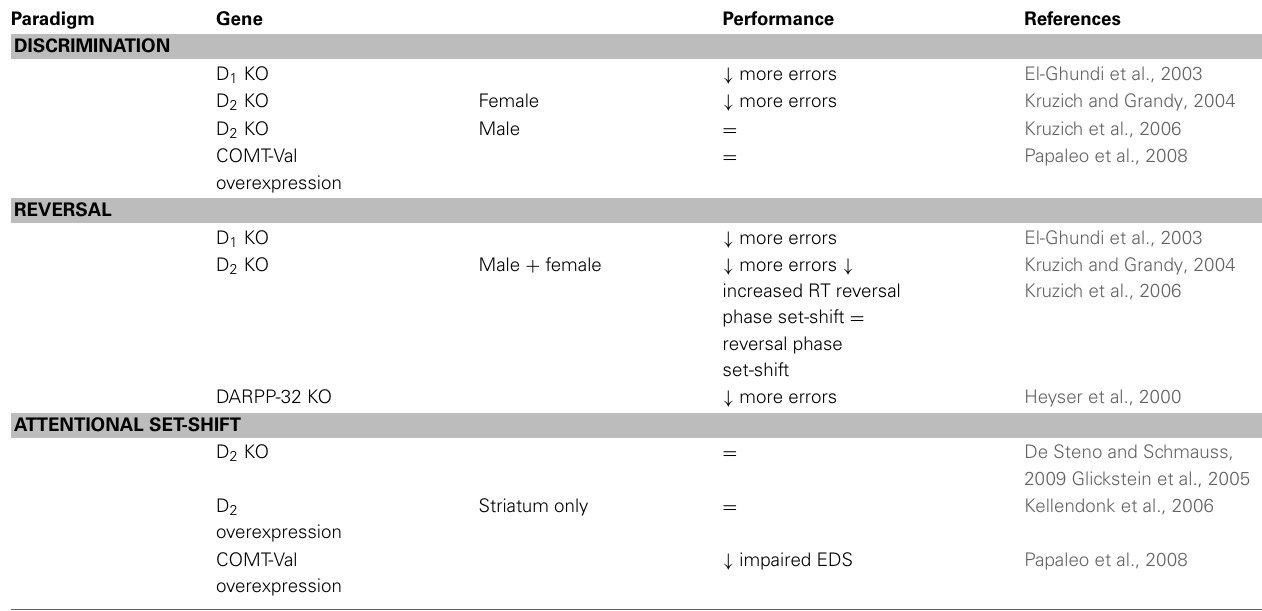
Table 4 | Effects of genetic manipulations to dopamine related genes on cognitive flexibility in animals. Paradigm